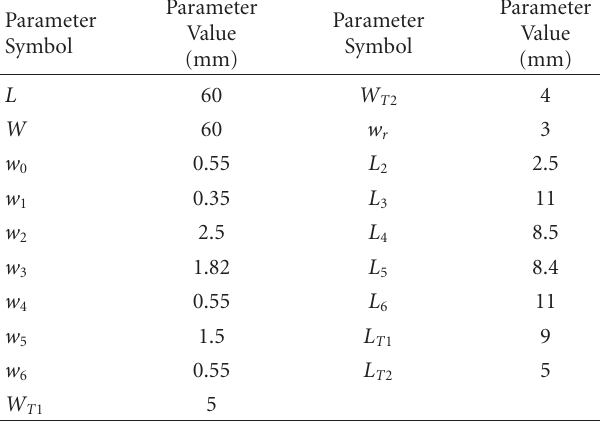
Figure 5: Measured and simulated scattering